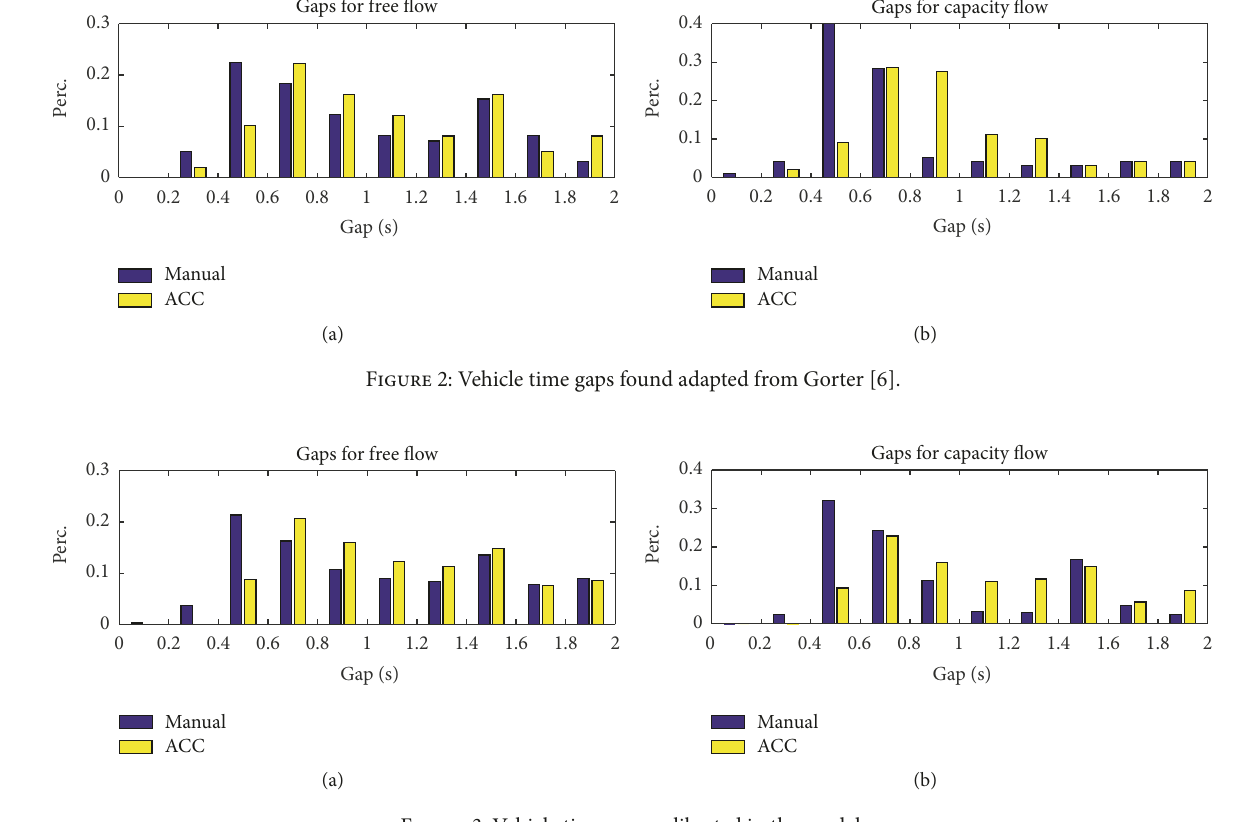
Figure 3: Vehicle time gaps calibrated in the